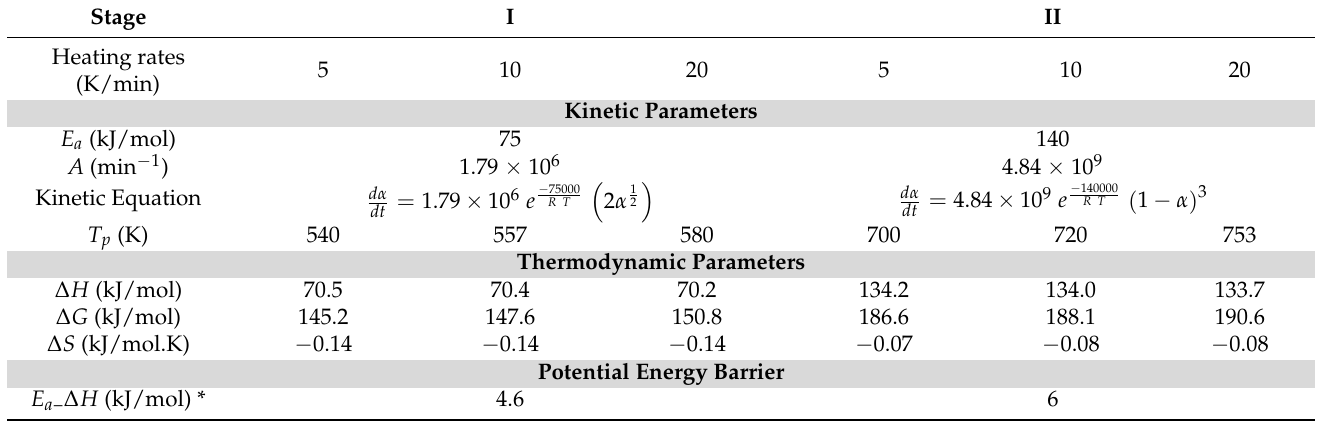
Table 9. Thermodynamic parameters estimated for the process of the pyrolysis of PVC. Stage I